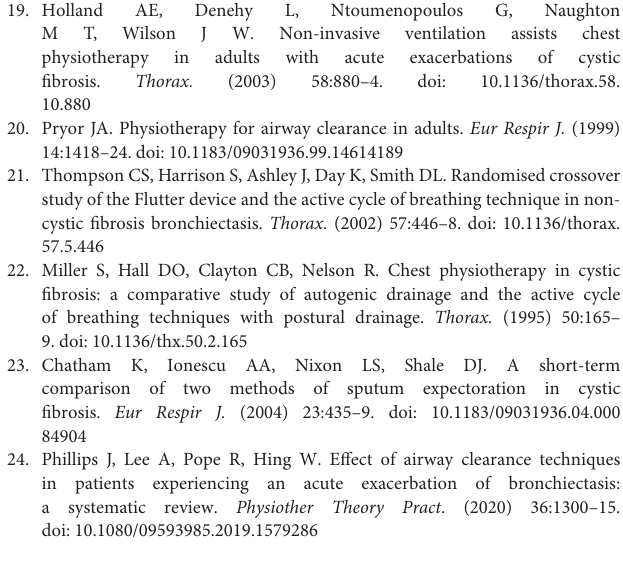
patients with lung resection: a quasi-experimental trial. Eur J Oncol Nurs. (2018) 34:1–7. doi: